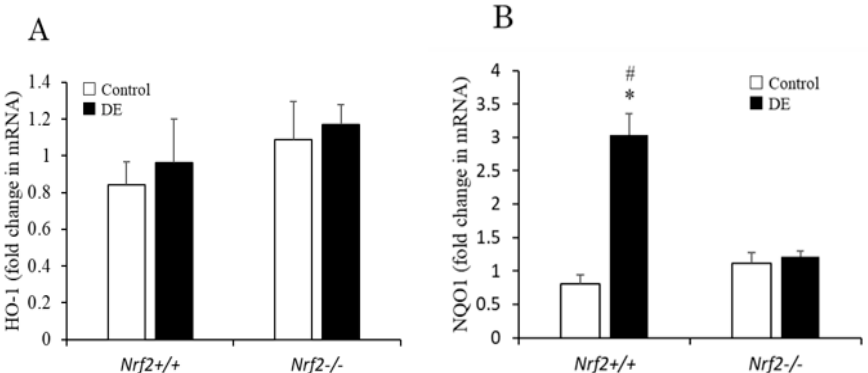
Figure 6. HO-1 ( A ) and NQO1 ( B ) mRNA expression levels in the lung tissues were analyzed using real time RT-PCR. The vertical axis shows percent changes in target gene mRNA expression levels of the DE group relative to the control group. β -actin was used as an internal control. Data are shown as mean ± SD values in each group ( n = 3). * p < 0.05 vs. control; # p < 0.05 vs. Nrf2 − / − .